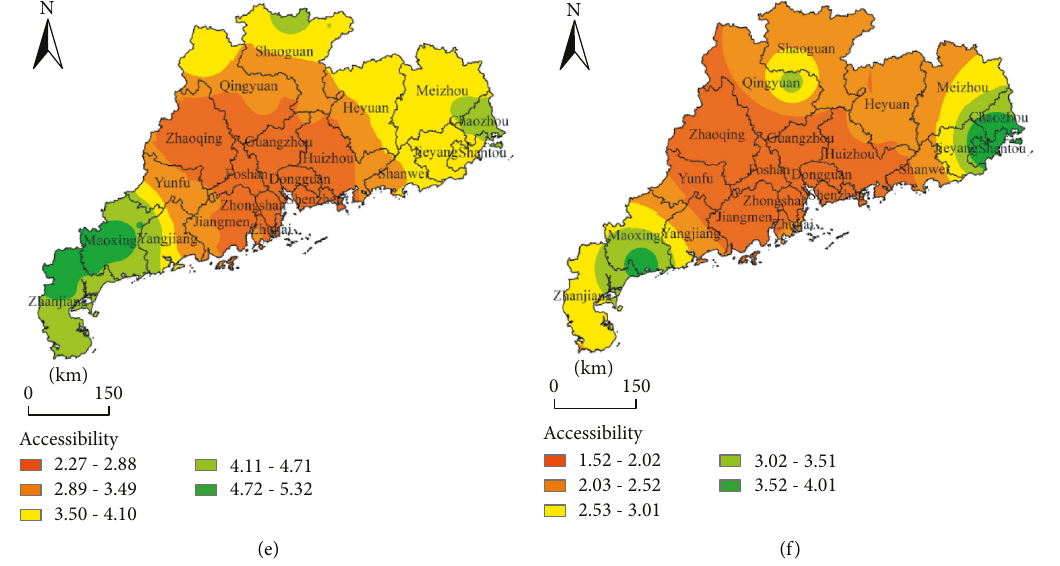
Figure 7: Accessibility analysis of Characteristic Towns in Guangdong Province (a) overall characteristic towns; (b) Industrial development type; (c) Agricultural service type; (d) Commercial circulation type; (e) Cultural tourism; (f) Innovative and creative.